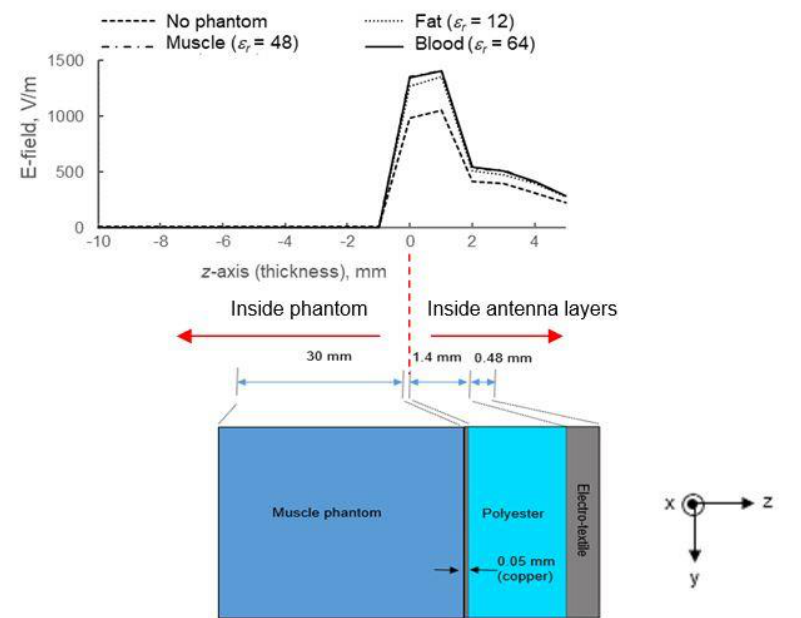
Figure 14. Graph of electric field intensities along antenna and phantom layers ( z -axis), which shows the di ff erence in E-field magnitude on the antenna surface for various ε r . As compared to the free space (no phantom) condition, the amount of E-field intensity (V / m) inside the antenna layer is higher in the presence of a phantom, which is expected due to the increase in Z in as observed in Figure